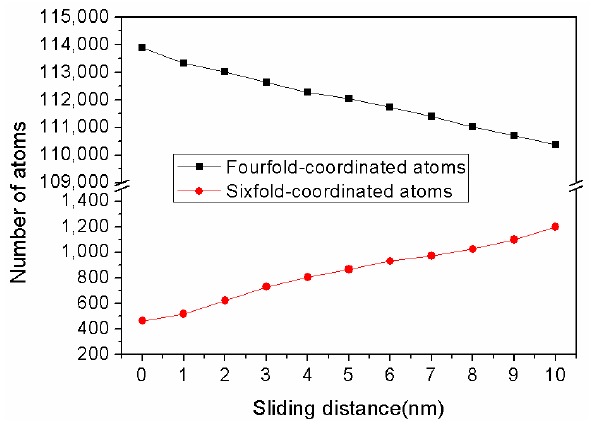
Figure 5. Variation of the number of atoms with coordination number in scratching F igure 5 Variation of the number of atoms with coordination number in scratching process.